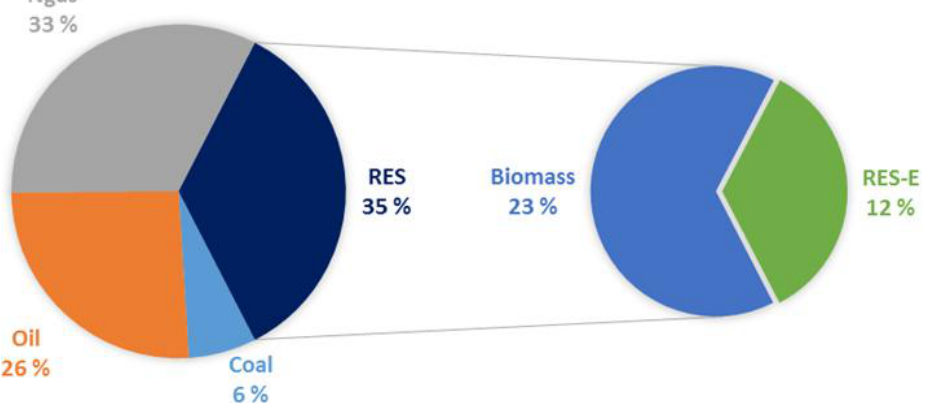
Figure 21. Fuel consumption in the Italian scenario with 35% RES.